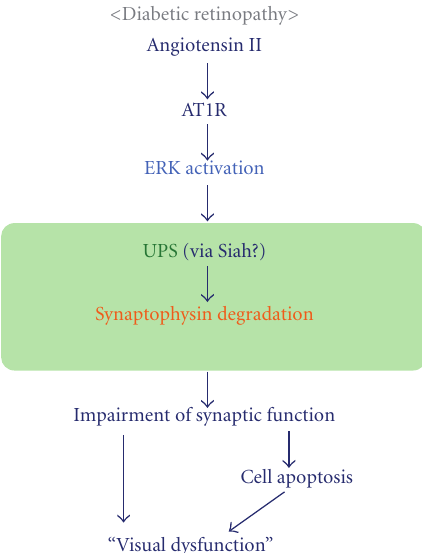
Figure 5: Model of the molecular mechanism in diabetic retinopathy. Angiotensin II binds to AT1R and induces ERK activation, resulting in excessive UPS-mediated synaptophysin protein degradation. This impairs synaptic activity, which is critical for visual function and neuronal cell